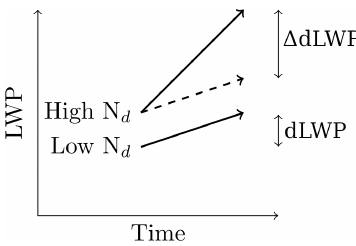
Figure 1. A schematic of the difference-in-differences method, showing how the N d impact on LWP development is identified using the temporal development of the cloud field. This exam- ple shows a positive (cid:49) dLWP. In Sect. 3.1 and 3.2, a threshold of 60cm − 3 is used to separate high and low N d